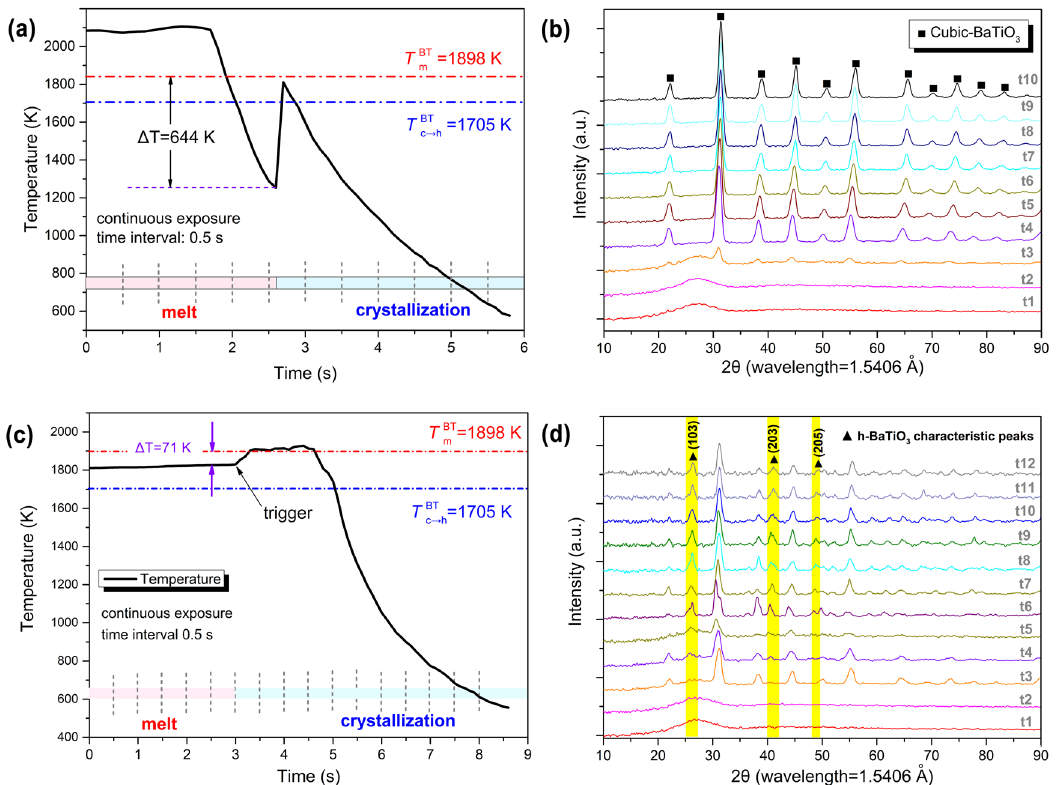
Fig. 2 Temperature – time pro fi le and in situ HEXRD patterns describing the crystallization process of BT melt. a , b Crystallization in supercooled condition ( Δ T = 644 K). c , d Being triggered at a small undercooling ( Δ T = 71 K). The highlight area represents the characteristic diffraction peaks of h -BT at 26.28°, 41.22°, and 49.10°. The raw data of 2 θ -intensity obtained by high-energy X-ray ( λ = 0.17835 Å) was converted into standard patterns, corresponding to Cu – K α target ( λ = 1.5406 Å), for a better comparison with standard PDF